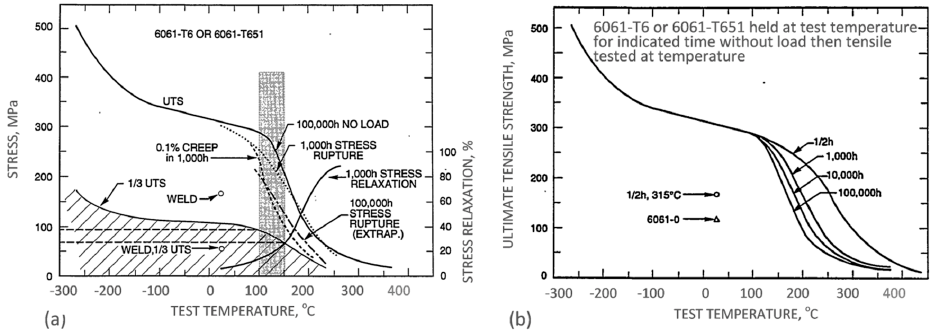
Figure 2. Example of property deterioration of the AA6061 aluminum alloy upon heating in air: ( a ) effect of temperature on creep and stress relaxation; ( b ) effect of temperature and time on ultimate strength [4].